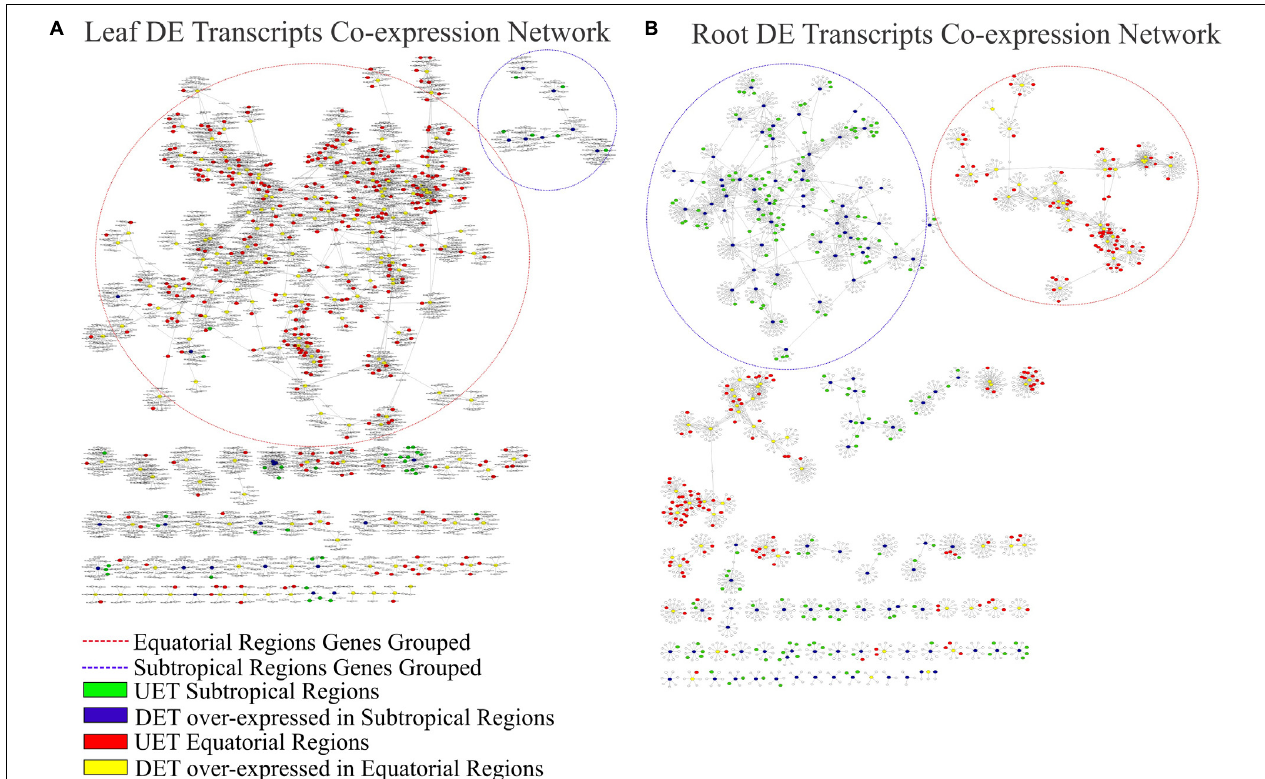
FIGURE 6 | Correlation networks of transcript expression in Rhizophora mangle . Circular nodes represent transcripts and edges represent the correlation between pairs of transcripts. The figures show differentially expressed transcripts (DETs) between populations and their first neighbors. A blue circle highlights one of the largest clusters of these networks, with a predominance of UETs and over-expressed transcripts detected in subtropical samples. A red circle highlights one of the largest clusters of these networks, with a predominance of UETs and over-expressed transcripts detected in equatorial samples. (A) Co-expression network of leaf transcripts. (B) Co-expression network of root